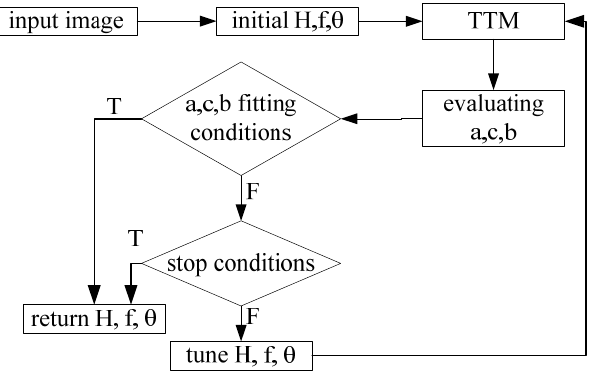
Figure 7. The flow chart of the fittest algorithm for parameters of